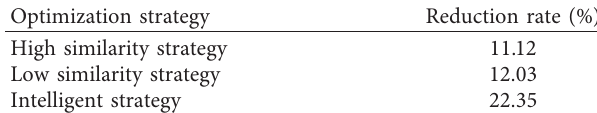
Table 8: Result statistics.